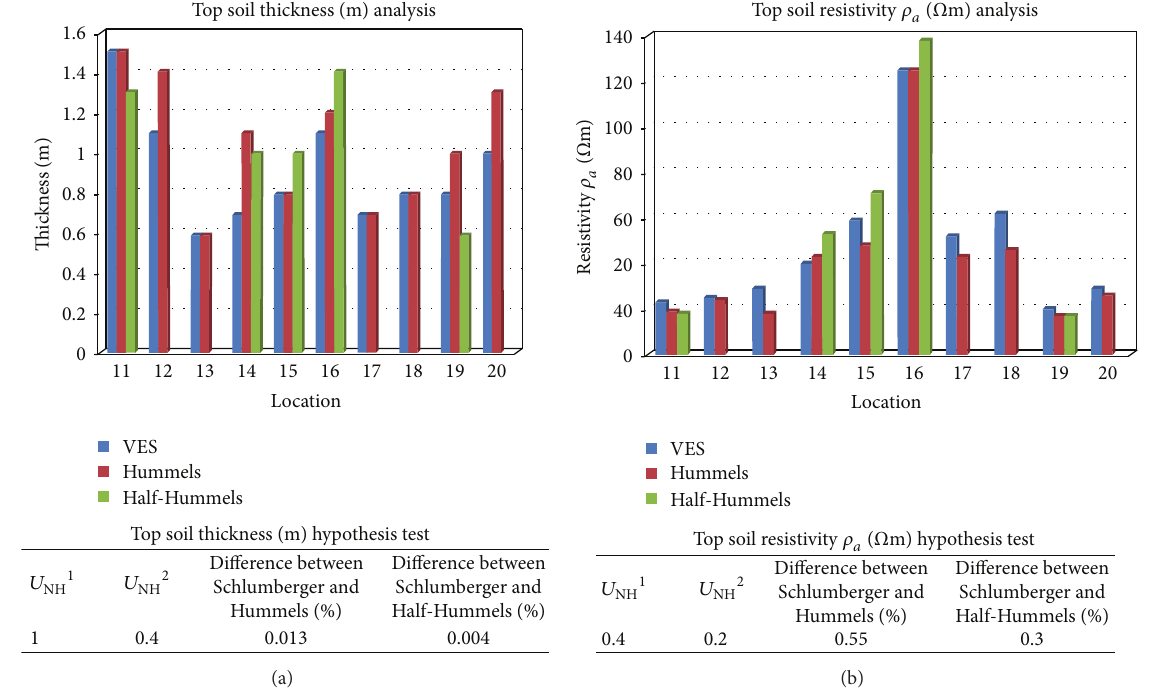
Figure 24: Bar chart and statistical test of hypothesis table for the different array methods comparing (a) topsoil thickness and (b) topsoil resistivity, for stations on amphibolite.